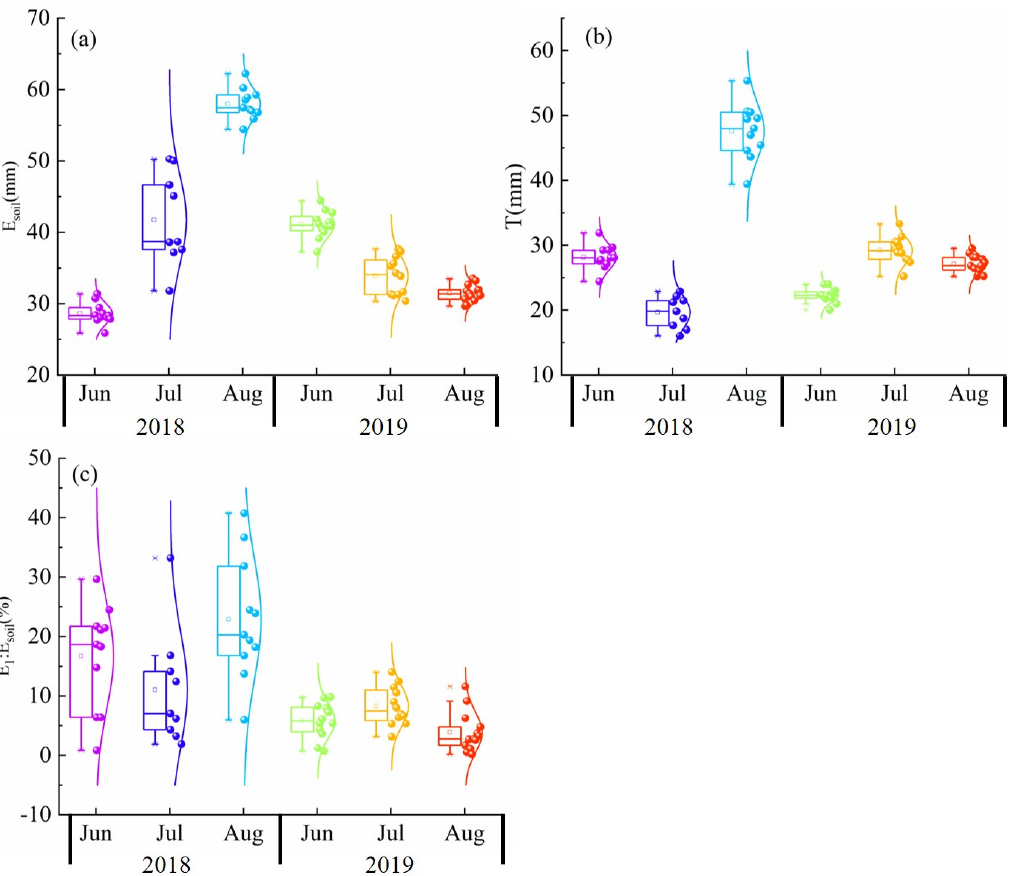
Figure 5. Temporal changes in soil evaporation ( E soil ) ( a ) and plant transpiration ( T ) ( b ) values and the proportion soil fractionation in soil evaporation ( E 1 : E soil ) ( c ) in summers of 2018 and 2019.